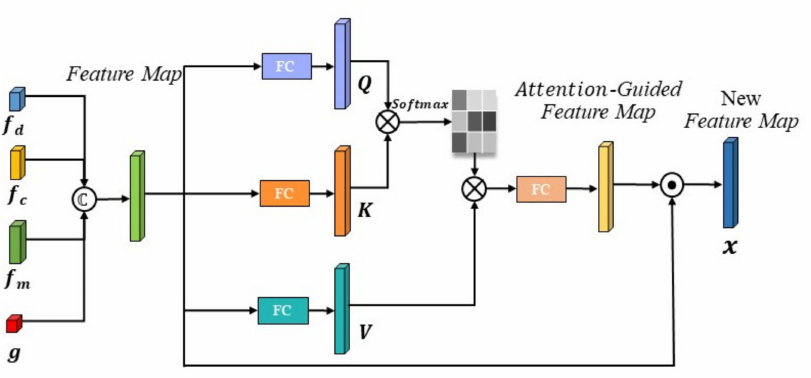
Figure 3. Attention fusion